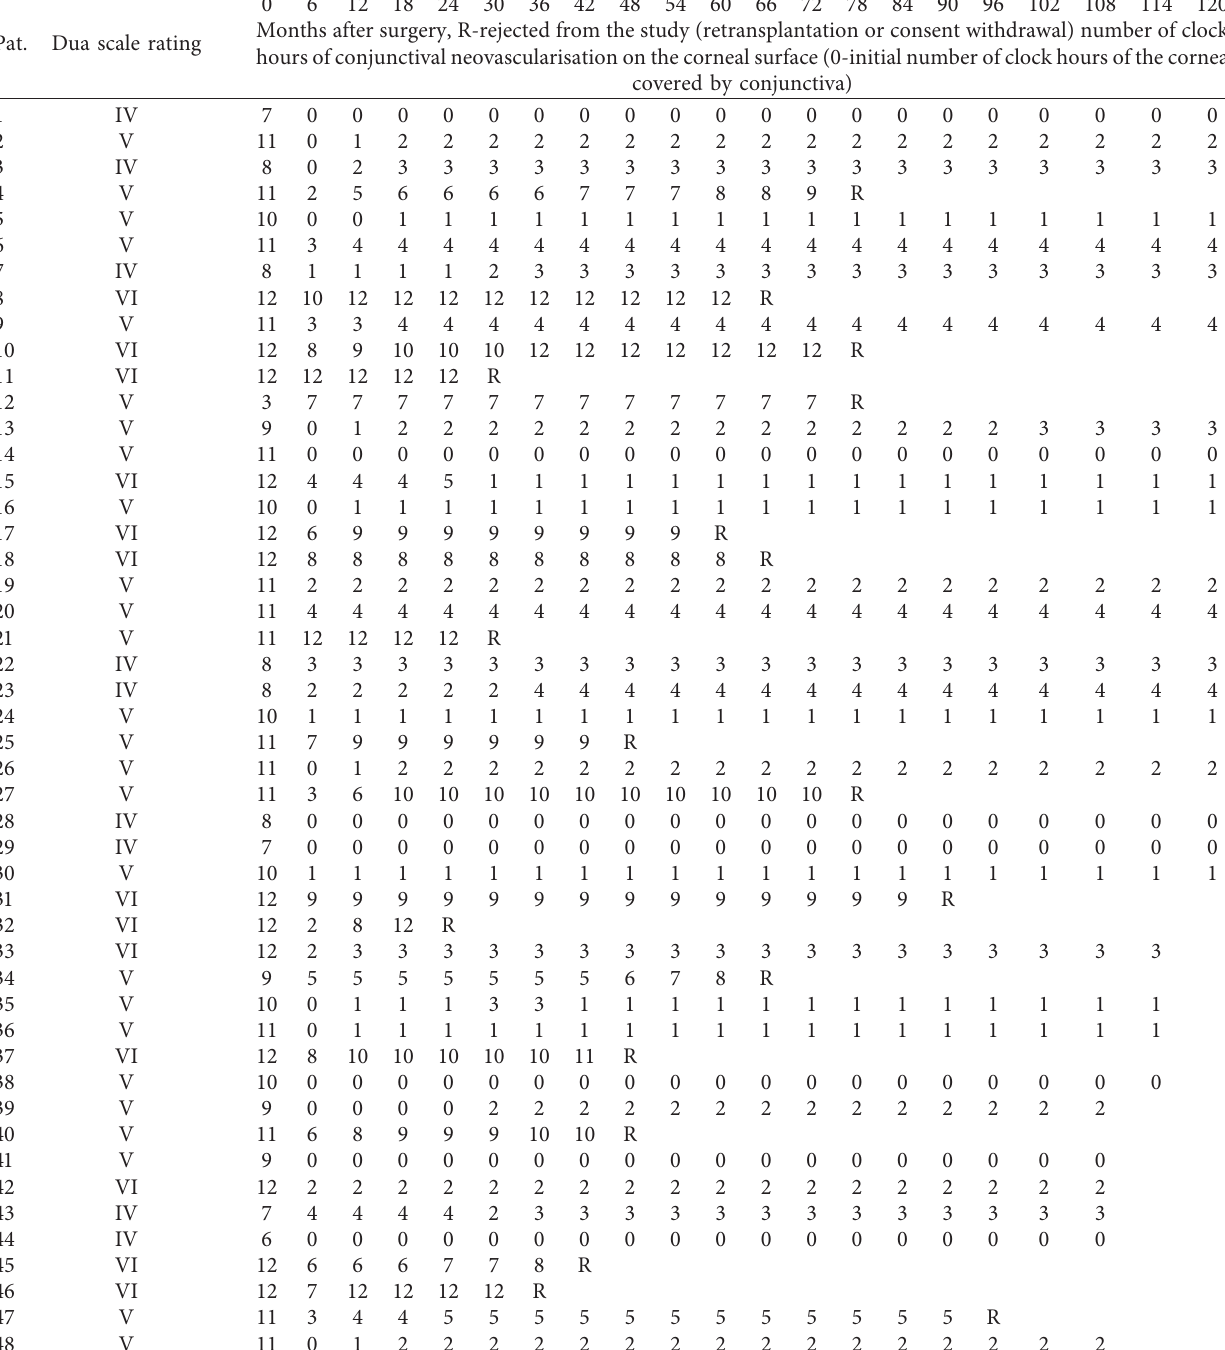
Table 2: Patients’ overview range of conjunctival ingrowth (clock hours) in each 6-month period of follow-up. Pat. Dua scale rating